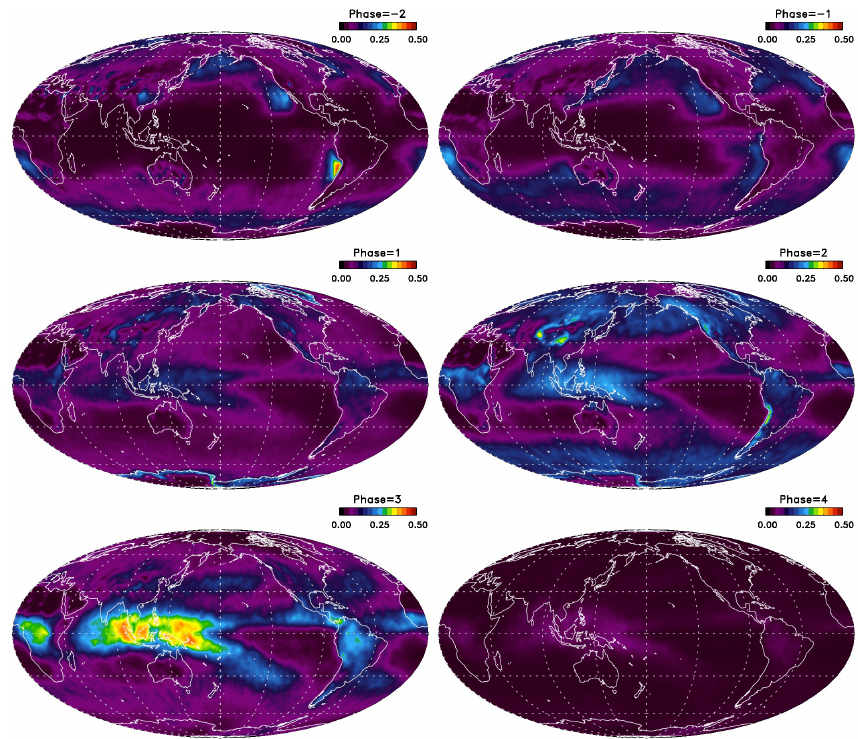
Fig. 6. The various phase tests for liquid (upper row) and ice (middle and lower rows) phases for 2007. In the case of liquid, − 2 indicates that the two liquid-phase tests were passed, and − 1 indicates only one of the two tests passed. In the case of ice phase, maps are shown for the number of ice-phase tests that passed (1–4). The relative frequencies of occurrence (% of total AIRS FOVs) for tests − 2, − 1, 1, 2, 3, and 4 are 7.9%, 8.3%, 6.7%, 10.7%, 8.2%, and 0.8%, respectively. Please refer to Sect. 3.1 for an explanation of each phase